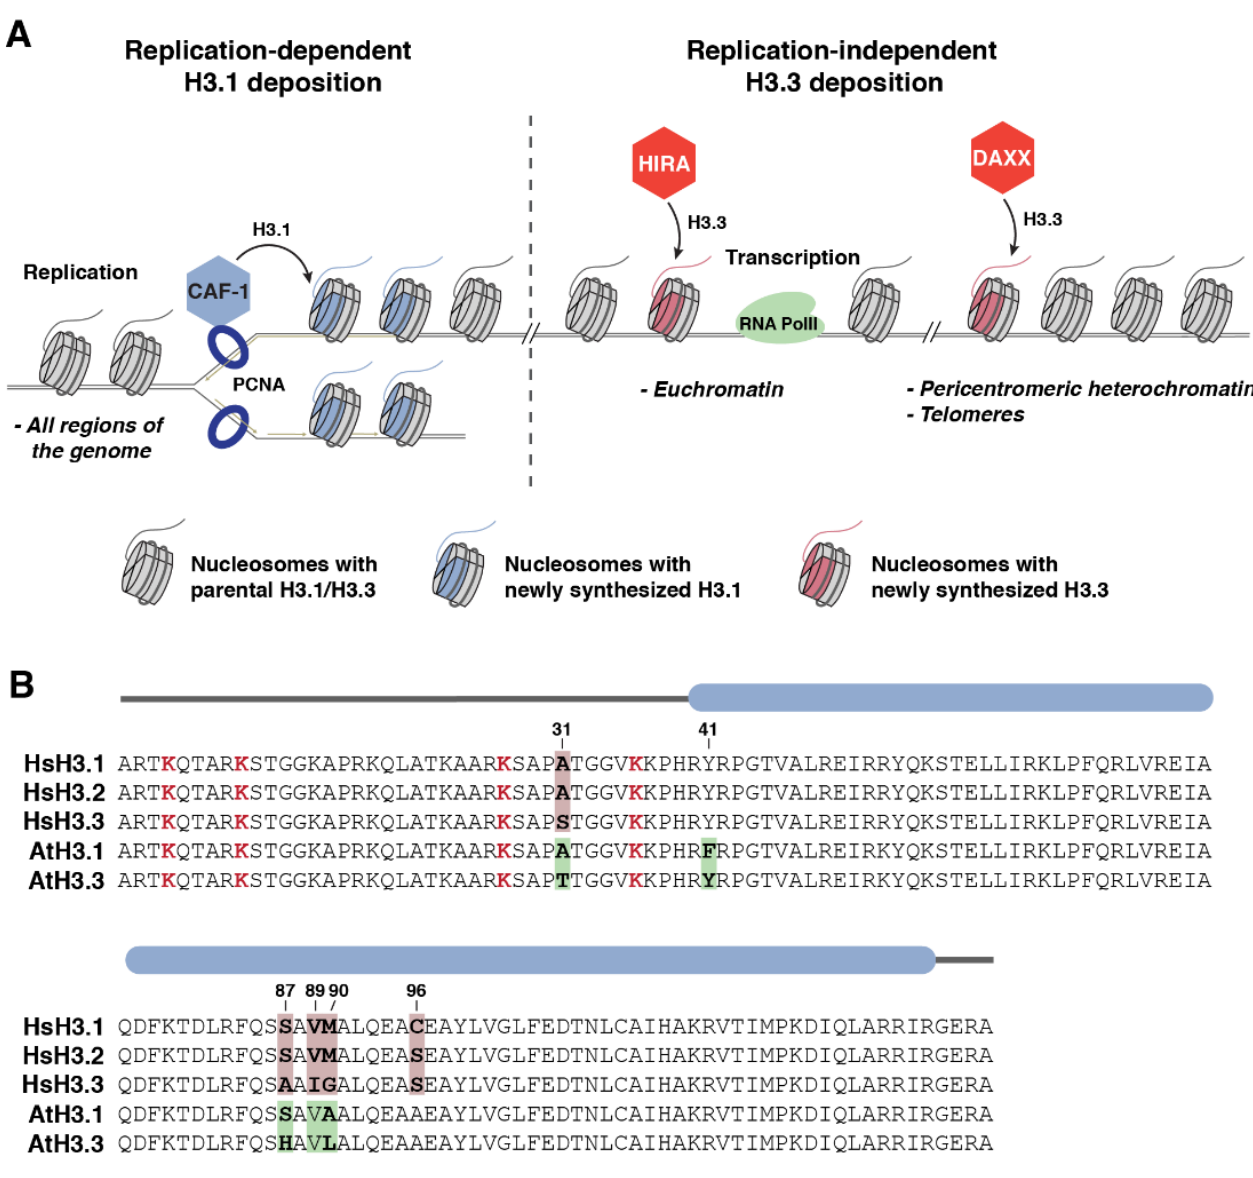
Figure 1. The distinct deposition pathways and sequences of histone H3.1 and H3.3 variants: ( A ) The deposition of H3.1 and H3.3 by their dedicated histone chaperones at different genomic loci. The CAF-1 complex directly interacts with the PCNA clamp and deposits H3.1 at replication forks during DNA replication. In contrast, HIRA inserts H3.3 at active gene regions (i.e., euchromatin) during transcription, while DAXX deposits H3.3 mainly at various heterochromatic loci, including pericentromeric regions and telomeres. Nucleosomes with parental H3.1 or H3.3 histones are shown in gray; nucleosomes with newly synthesized H3 proteins are highlighted in blue (H3.1) or red (H3.3); ( B ) sequence alignment of histone H3 variants (H3.1/H3.2 and H3.3) from human and Ara- bidopsis. The sequence folding into the globular domain of H3 is marked by a blue rounded rectan- gle. Functionally important lysine residues (i.e., K4, K9, K27, and K36) in the N-terminal tails of H3 variants are highlighted in red. Sequence variations between H3.1, H3.2, and H3.3 in humans and Arabidopsis are indicated in pink and green, respectively, with positional information for these var- iable amino acids indicated above the alignment.